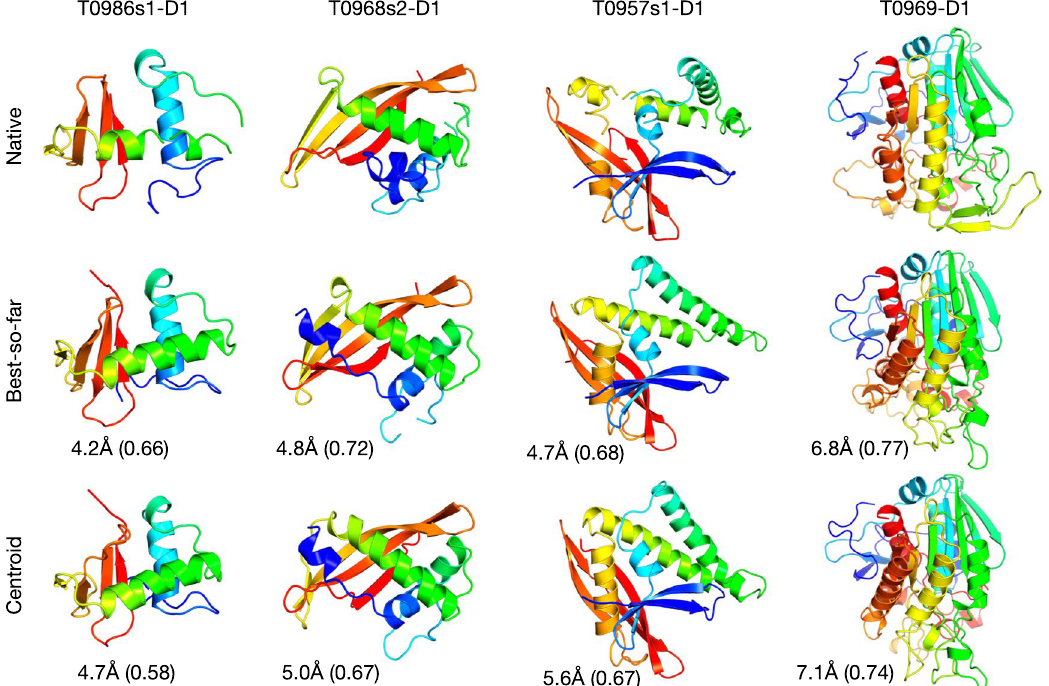
Figure 4. The predicted structures of four representative TFM targets using the torsion angles estimated by the ESIDEN. The cartoon structures were made by PyMOL 49